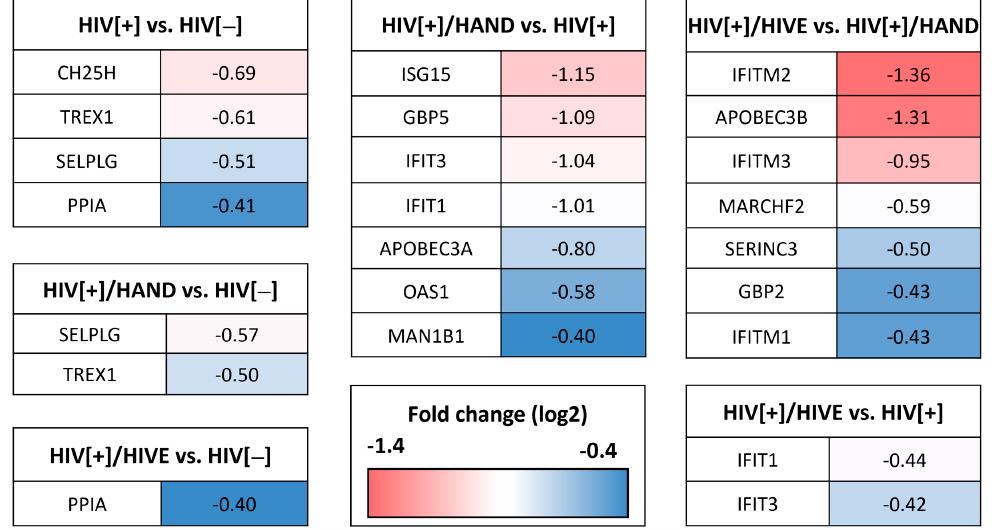
Figure 5. Comparison of downregulated restriction factors in different experimental groups. Restriction factors with a minimum − 0.4 log2 fold change (0.75 fold change) were selected from different group comparisons based on the RNA-seq dataset. The most downregulated genes belonged to the two HIV[+] groups with HAND, where IFITM2 and APOBEC3B had − 1.36 and − 1.31 log2 fold change downregulation in the HIV[+]/HAND group compared to the HIV[+]/HIVE group, respectively.